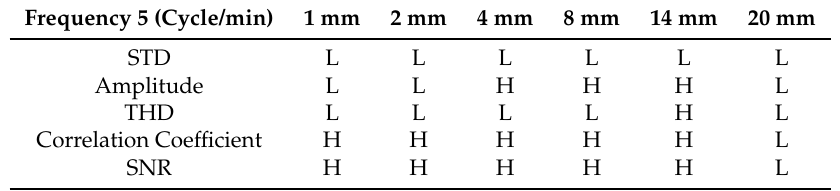
Table A11. Values higher and lower than the median for Frequency of 5 cycles/min for a 5 mm band.